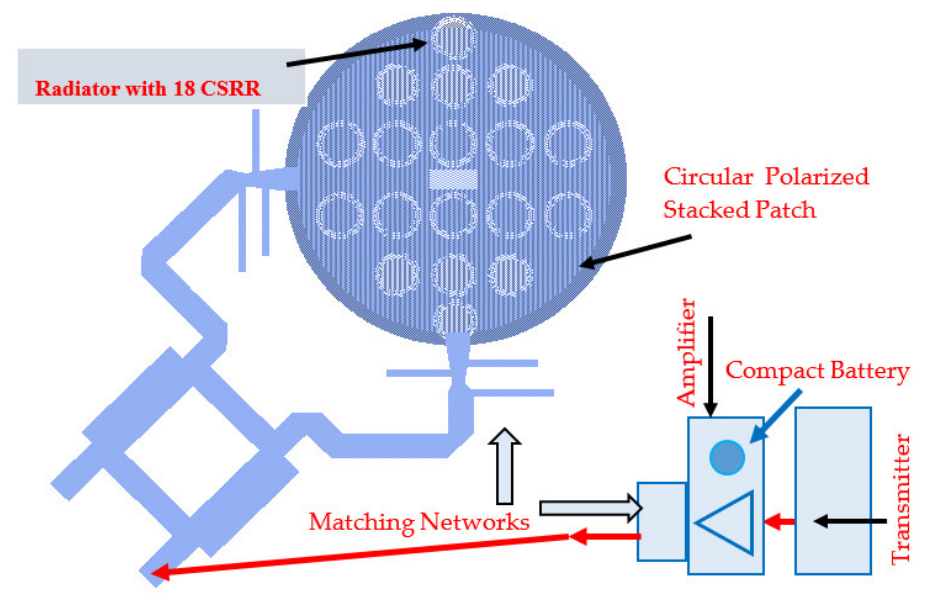
Figure 13. Transmitting channel block diagram with a wearable active transmitting sensor.